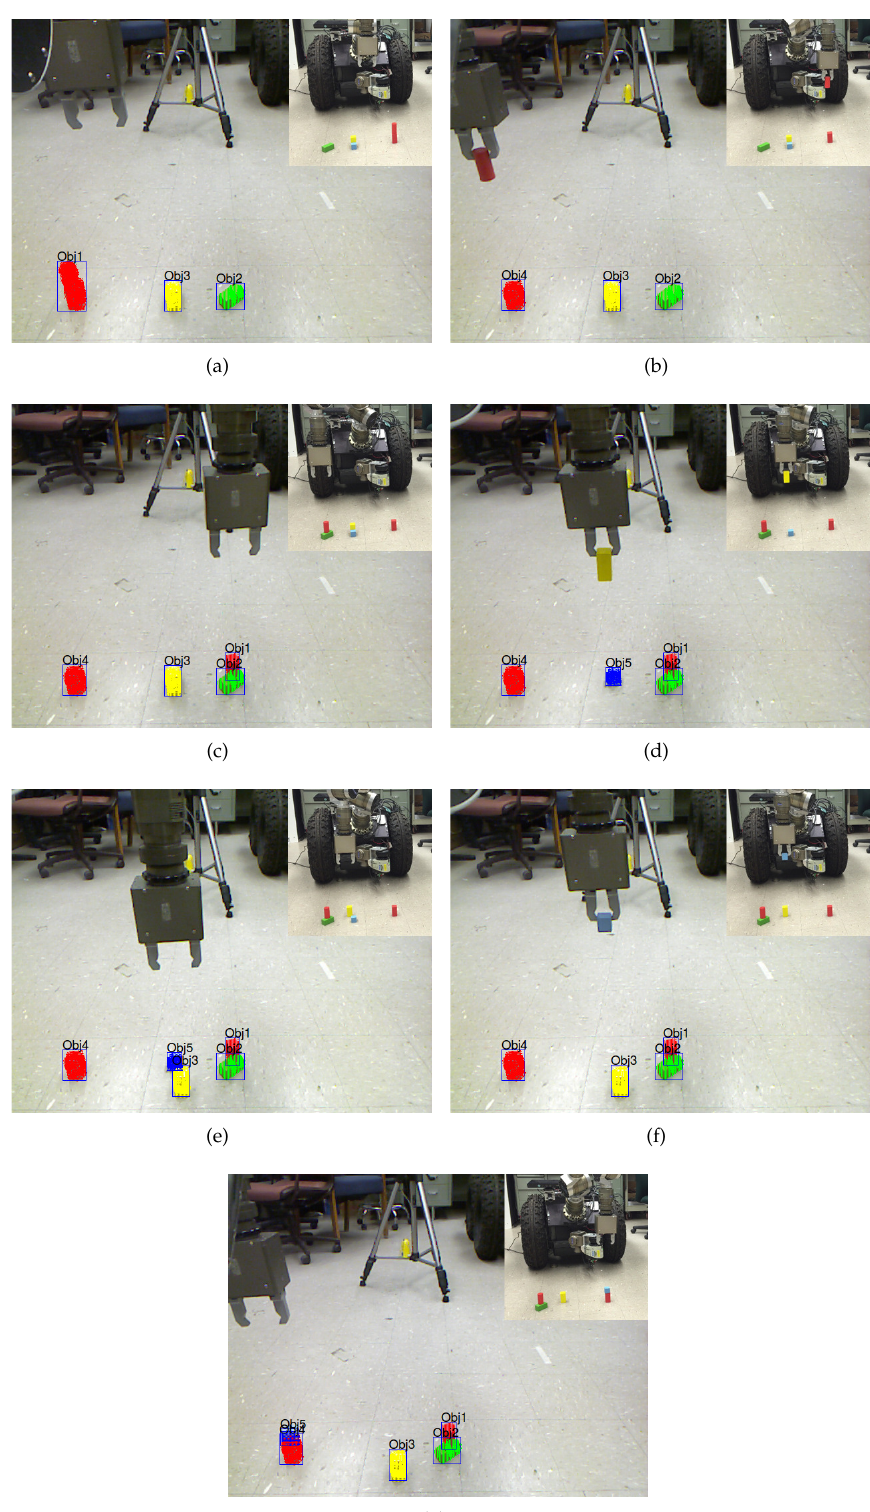
Figure 11. The block manipulation process at discrete time steps ( a – g ). At each time step t , the segmented objects are updated after executing the NL instruction at time step t − 1. ( a ) Time step 0: Pick up the red object; ( b ) Time step 1: Put it down to the rightmost green block; ( c ) Time step 2: Pick up the yellow block; ( d ) Time step 3: Put it down to the ground that is in front of the blue block; ( e ) Time step 4: Pick up the blue block; ( f ) Time step 5: Put it down to the leftmost red block; ( g ) Time step